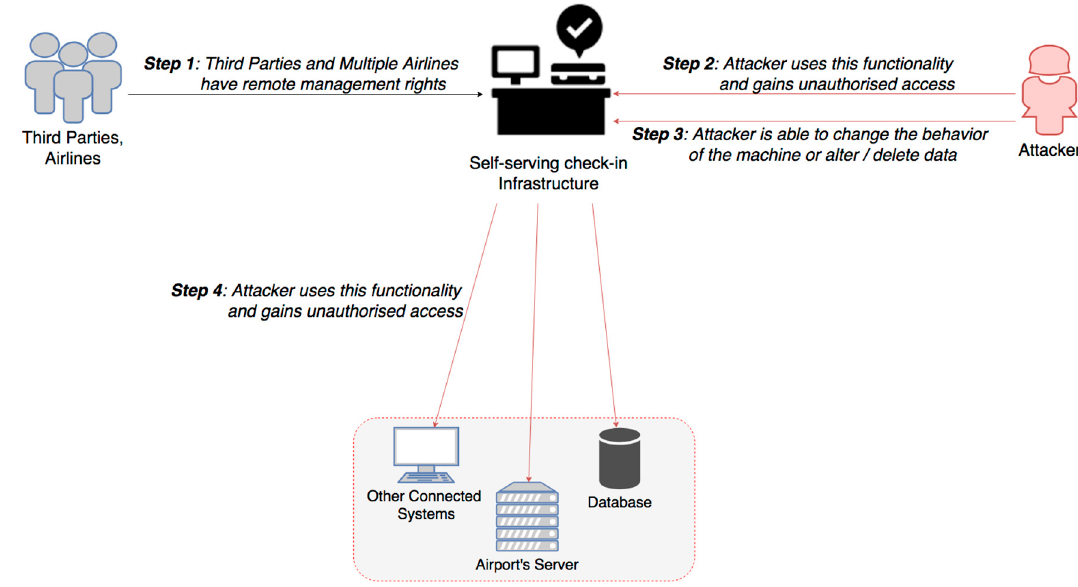
Figure 10. Tampering with airport self-serving systems.